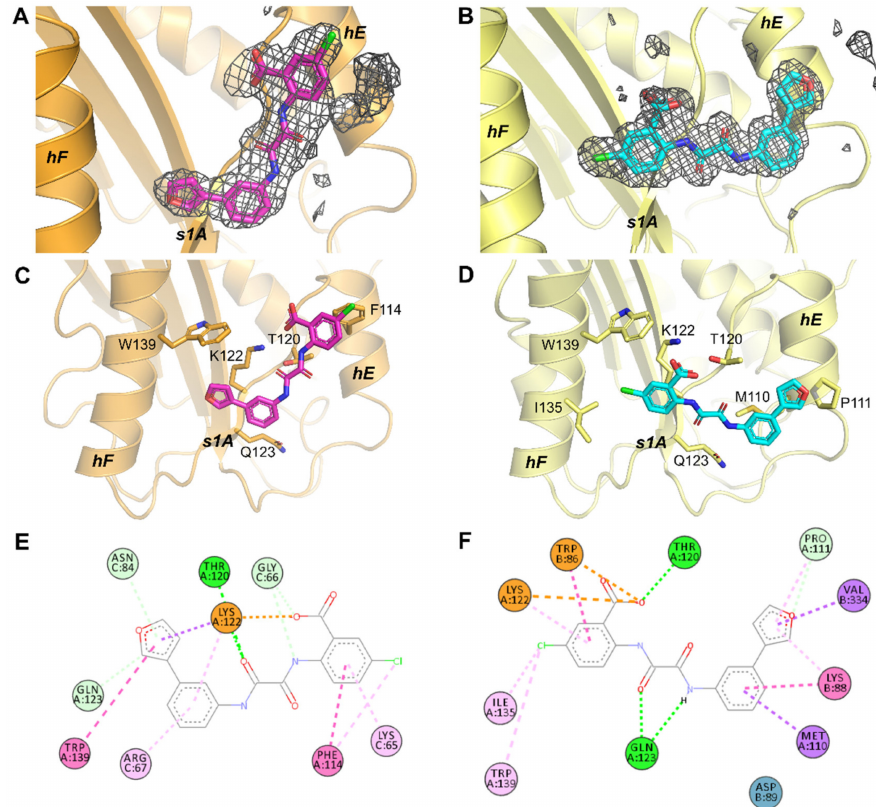
Figure 3. X-ray crystallographic structures of TM5484 bound to PAI-1. ( A ) Phenix.polder difference maps contoured at 4 sigma for TM5484 inside the PAI-1-W175F/Nb42/Nb64 crystal. PAI-1-W175F is colored orange and TM5484 is colored magenta. ( B ) Phenix.polder difference maps contoured at 4 sigma for TM5484 inside the PAI-1-stab crystal. PAI-1-stab is colored yellow and TM5484 is colored cyan. ( C , D ) Cartoon representation of the structure of the TM5484-bound PAI-1- W175F/Nb42/Nb64 complex and TM5484-bound PAI-1-stab. PAI-1-W175F is shown in orange and PAI-1-stab in yellow. TM5484 associated with PAI-1-W175F is colored magenta, whereas TM5484 associated with PAI-1-stab is colored cyan. Side-chains of the residues engaged in interactions with TM5484 are indicated and shown as sticks. ( E , F ) Two-dimensional diagrams of the relevant non-covalent protein-compound interactions as detected and visualized by Discovery Studio Visualizer. ( E ) Interactions between TM5484 and PAI-1-W175F. Residues in PAI-1-W175F are indicated by prefix “A” and residues in Nb64 of the neighboring asymmetric unit (ASU) are indicated by prefix ‘C’; ( F ) Interactions between TM5484 and PAI-1-stab. Residues in one PAI-1-stab molecule are indicated by prefix “A” and residues in the PAI-1-stab molecule of the neighboring ASU are indicated by prefix “B”. Conventional hydrogen bonds are presented as green dashed lines. Carbon hydrogen bonds and π -donor hydrogen bonds are presented as light green dashed lines. Salt bridges (Lys122) and pi-anion interactions (Trp86) are presented as orange dashed lines. ππ and amide- π stacking interactions are presented as pink dashed lines. π -alkyl and alkyl interactions, including edge-on Cl- π interactions, are presented as light pink dashed lines. π -sigma interactions are presented as purple dashed lines. Asp89 (blue) is involved in a van der Waals